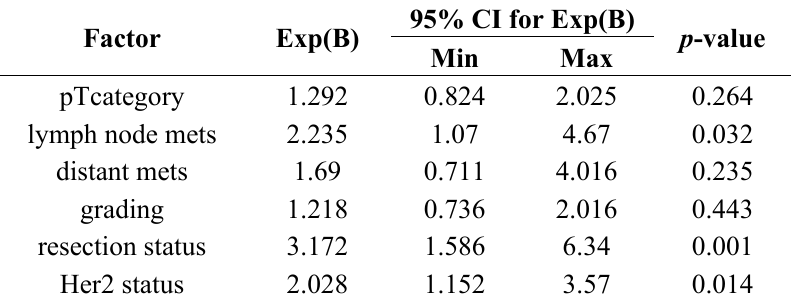
Table 5. Multivariate analysis of prognostic relevant